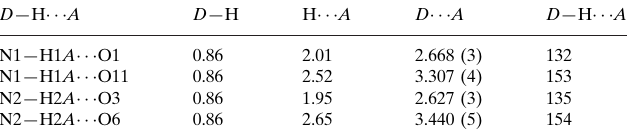
30011 measured reflections 8464 independent reflections 7465 reflections with I > 2 (cid:2) ( I ) R int = 0.024 H atoms treated by a mixture of independent and constrained refinement (cid:2) (cid:7) max = 1.23 e A˚ (cid:4) 3 (cid:2) (cid:7) min = (cid:4) 0.51 e A˚ (cid:4) 3